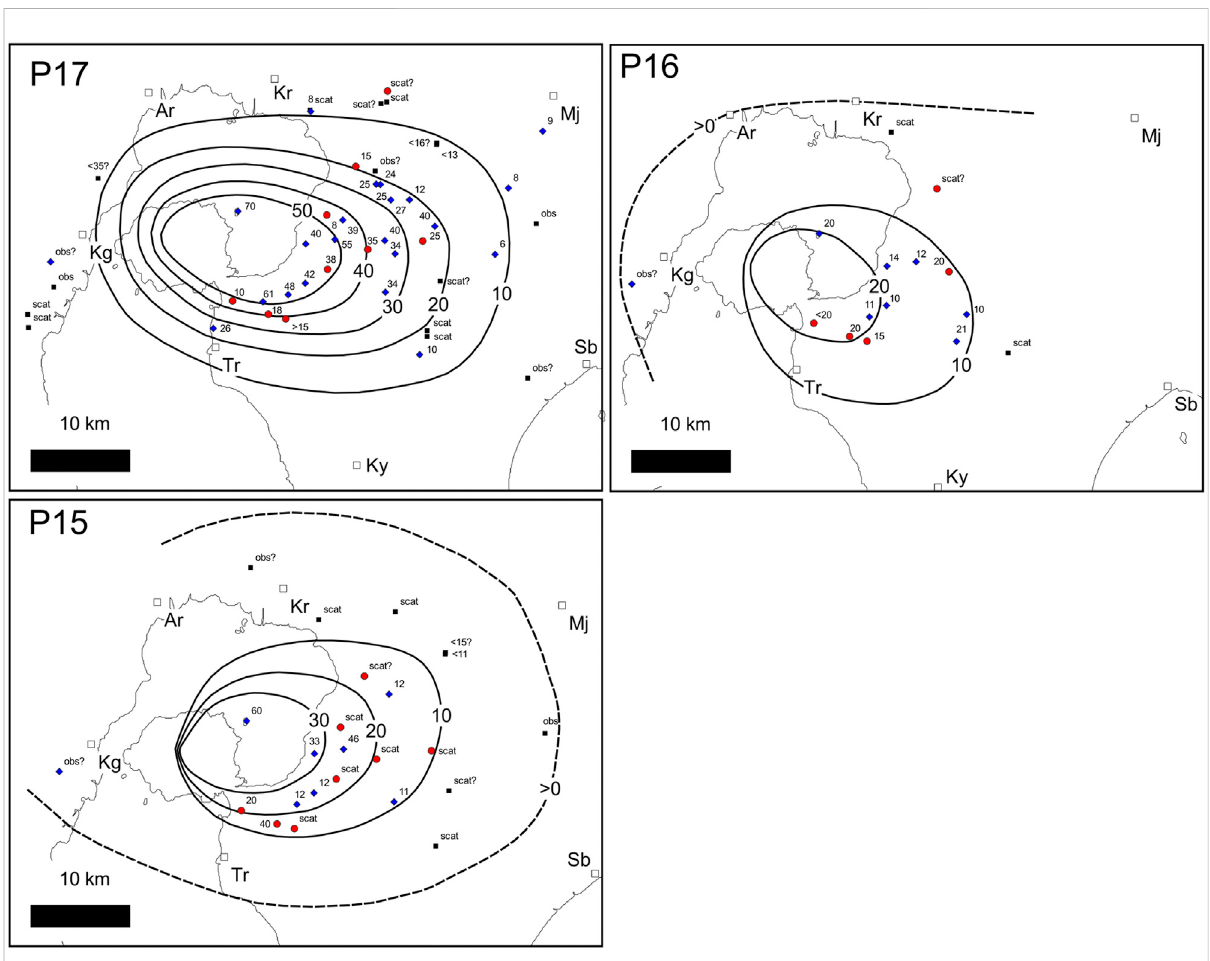
FIGURE 5 Distributions of the P17-P15 pumice fall deposits. Legend is the same in Figure 3A. The abbreviations associated with the measurement points arethefollowingmeaning;scat:outcropswherepumicelapilliwasscatteredinthesoil,obs:localitiesthattephradepositswereobservedwithoutno information about lithofacies and thickness, tr: localities where tephra-derived volcanic glass and minerals were detected in soil sample analysis, although not discernible to the naked eye. Solid white squares indicate the location of major cities, and the abbreviations are the followings: Ar, Aira city; Kg, Kagoshima city; Kr, Kirishima city; Mj, Miyakonojo city; Sb, Shibushi city; Tr, Tarumizu